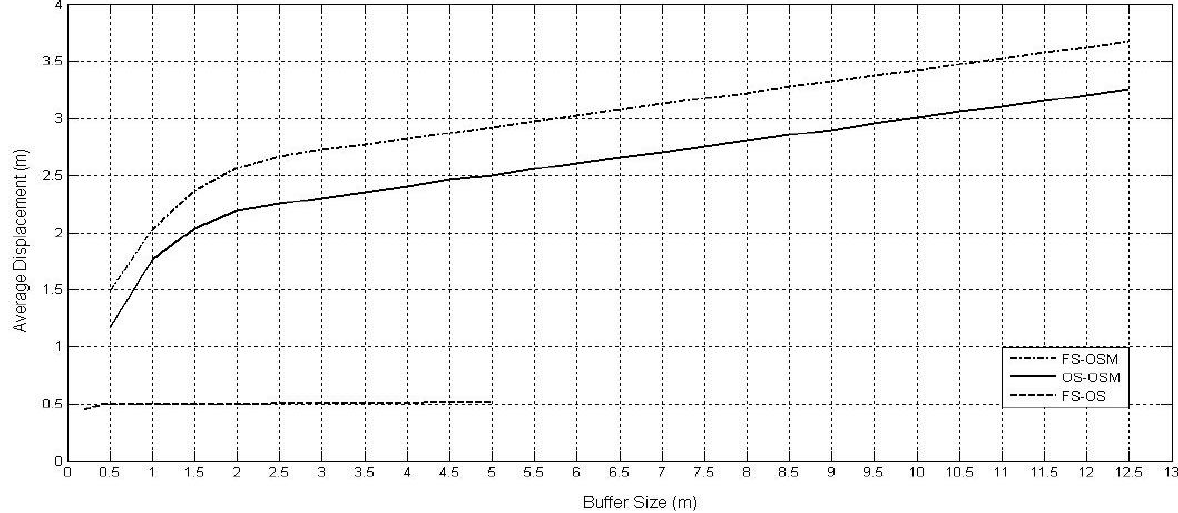
Figure 6. Average displacement information of roads in an urban area, UK.